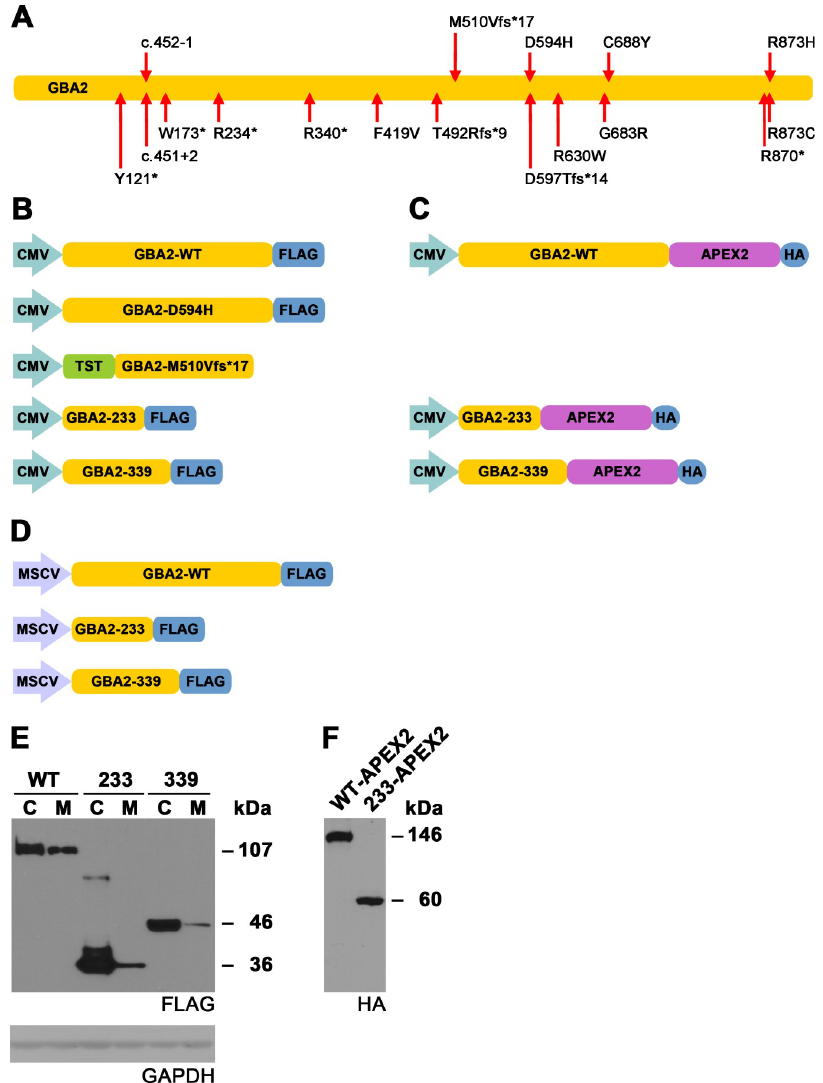
Fig 1. Expression of GBA2-WT and mutant forms of GBA2. (A) Schematic overview of mutations identified in the GBA2 gene in hereditary spastic paraplegia 46 (SPG46) [18–27] and Marinesco-Sjo¨gren-like syndrome (M510Vfs � 17) [28]. Indicated are the consequences of the GBA2 mutations at the amino acid level, except for two intronic mutations for which the nucleotide changes (c.) are indicated. (B) Schematics of the constructs used in this study for the expression of various forms of GBA2 under the control of the CMV promoter: GBA2-WT, the missense mutant D594H, and the nonsense mutants terminating at residues 233 and 339 (GBA2-233 and GBA2-339), all carrying a C- terminal FLAG tag, and the frameshift mutant M510Vfs � 17 carrying an N-terminal twin-strep-tag (TST). (C) Schematics of the constructs used in this study for the expression of C-terminally APEX2-tagged forms of GBA2-WT, GBA2-233, and GBA2-339, under the control of the CMV promoter. (D) Schematics of the constructs used in this study for the expression various C-terminally FLAG-tagged forms of GBA2 under the control of the MSCV LTR: GBA2-WT, GBA2-233, and GBA2-339. Note: schematics in [B], [C], and [D] are not drawn to scale. (E) Western blot showing the relative levels of GBA2-WT-FLAG, GBA2-233-FLAG, and GBA2-339-FLAG in U2OS cells under different promoters; C, CMV promoter; M, MSCV LTR. (F) Western blot showing the expression of APEX2-HA- tagged forms of GBA2-WT and GBA2-233; apparent molecular weights are